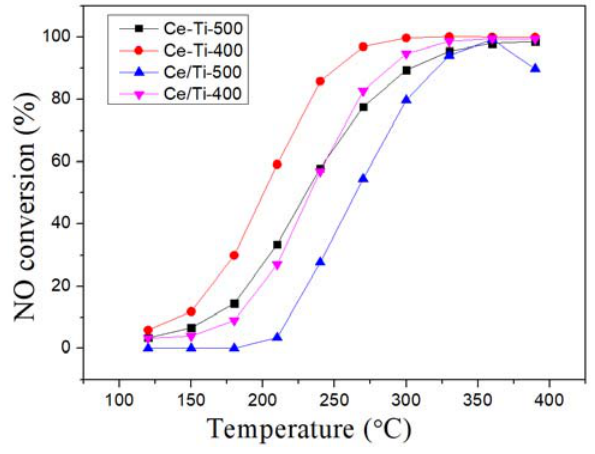
Figure 1. NO removal of Ce-Ti-500, Ce-Ti-400, Ce/Ti-500 and Ce/Ti-400 at different